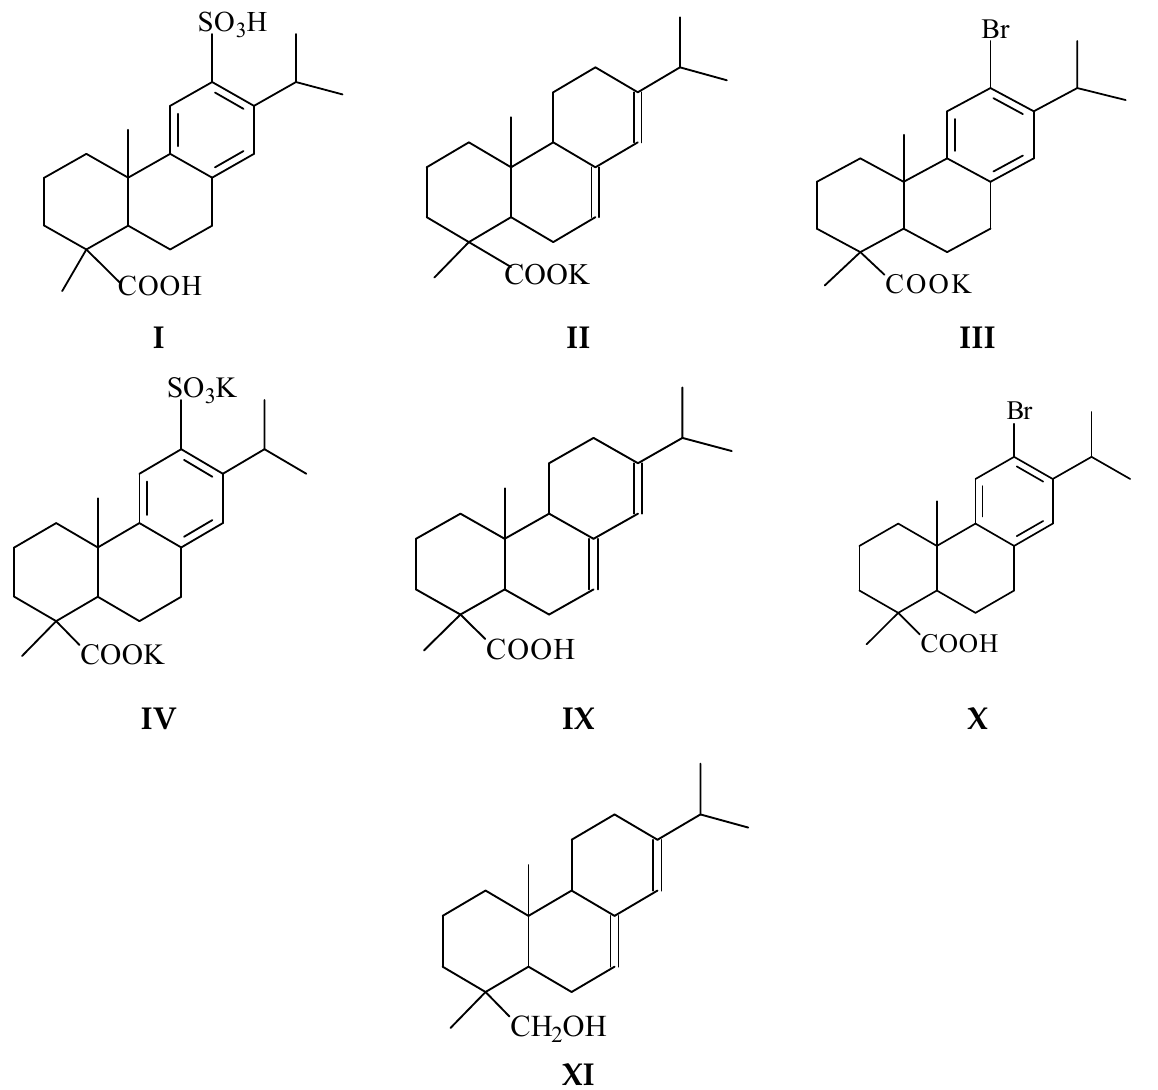
Figure 1. Compounds: ( I ). 12-sulfodehydroabietic acid, ( II ). Potassium abietate, ( III ). Potassium 12-bromodehydroabietate, ( IV ). Potassium 12-sulfodehydroabietate, ( IX ). Abietic acid, ( X ). 12-bromodehydroabietic acid, ( XI ). Abietinol.